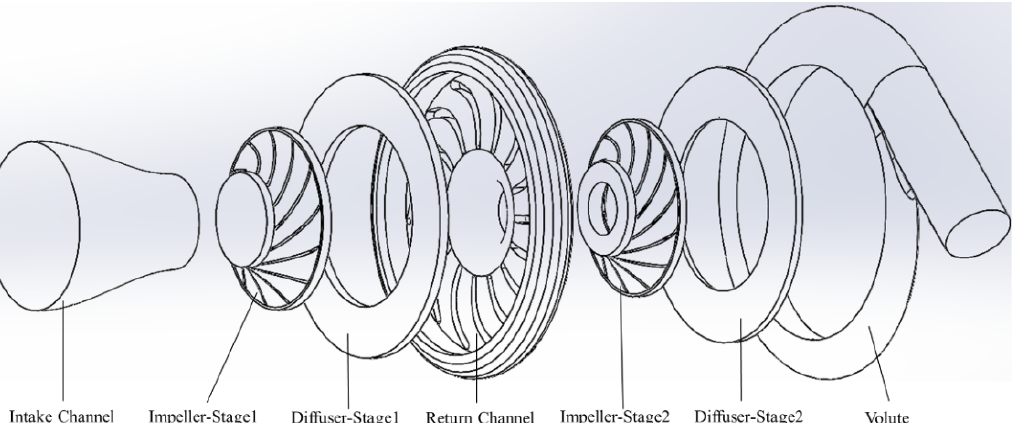
Figure 1. Exploded diagram of 150USRT class two-stage centrifugal compressor flow element con-